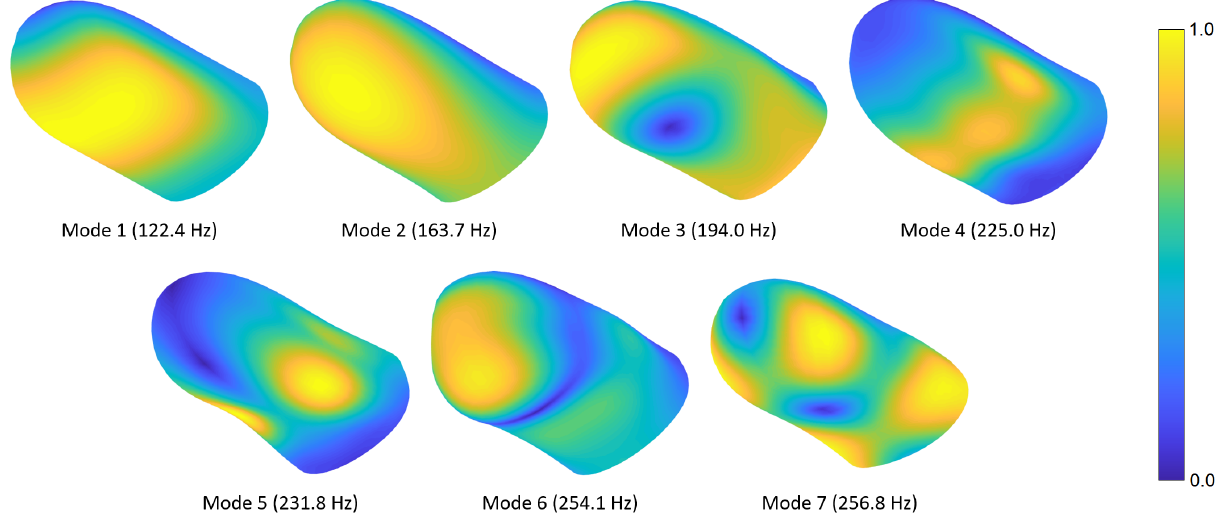
Figure 4. DigiTip’s first seven mode shapes and corresponding natural frequencies. The contours indicate equivalent displacement